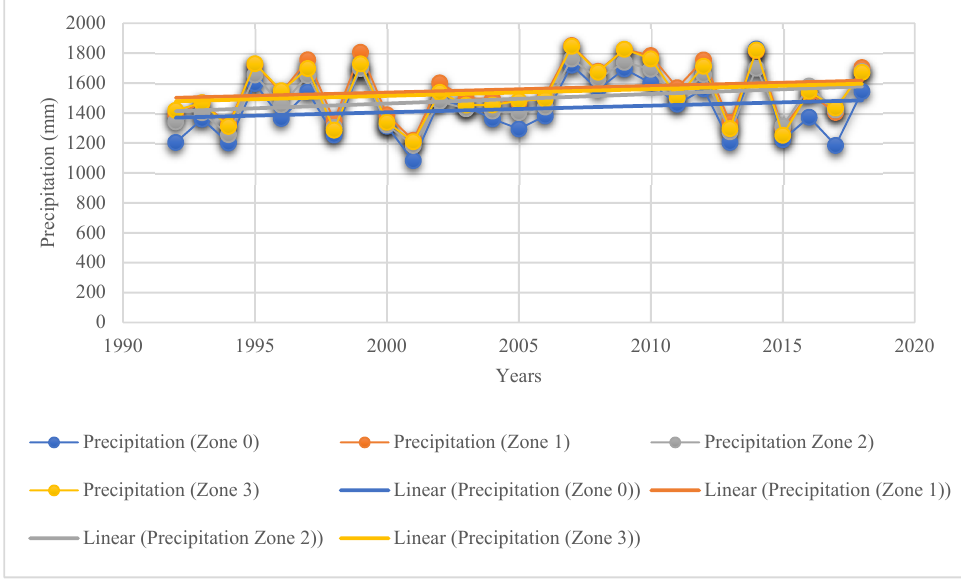
Figure 8. Regression model for yearly total precipitation calculation based on gridded population density-based urban development zone over Lagos study region. Table 7. Linear Regression Results When Gridded Population Density is Considered. Trendline for Zone Slope R-Square